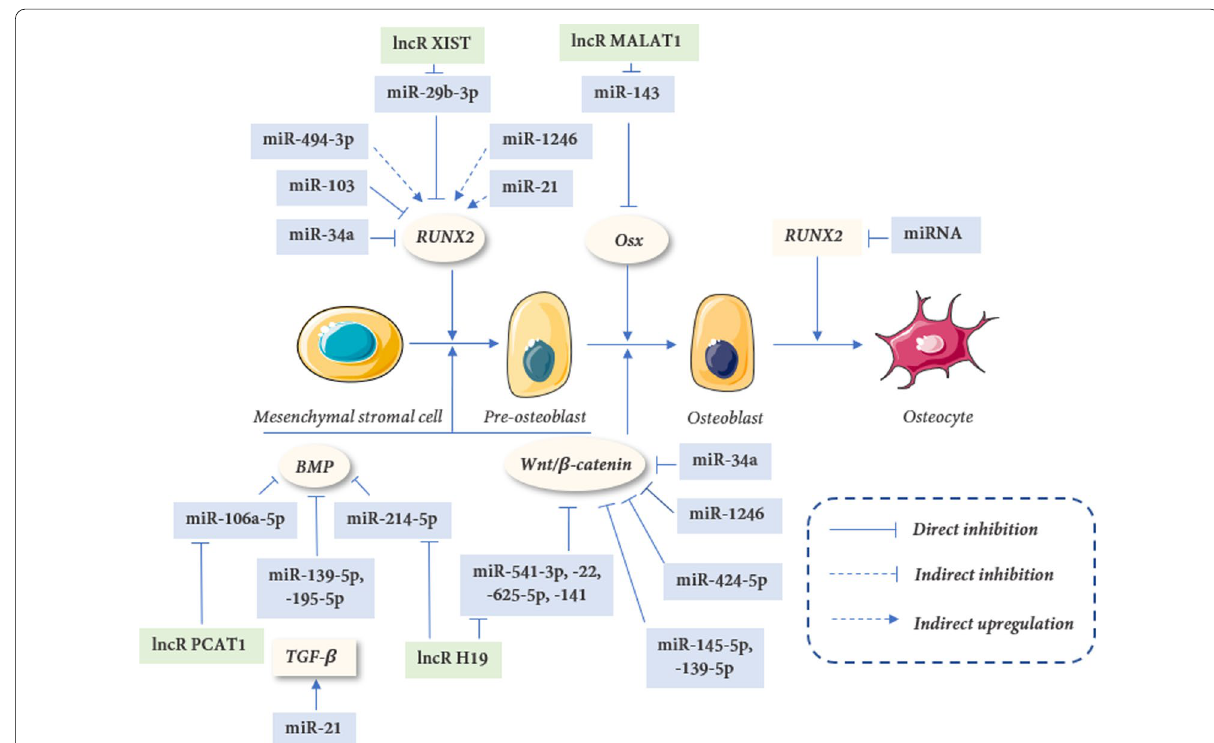
Fig. 4 Mechano-sensitive miRNAs and lncRNAs in osteogenesis: The microRNAs and long non-coding RNAs are regulated by mechanical force and are implicated in osteogenesis through regulating gene targets in mesenchymal stem cells, pre-osteoblasts, osteoblast cells, and